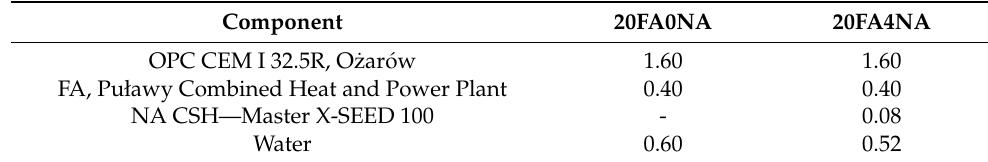
Table 1. Mixture